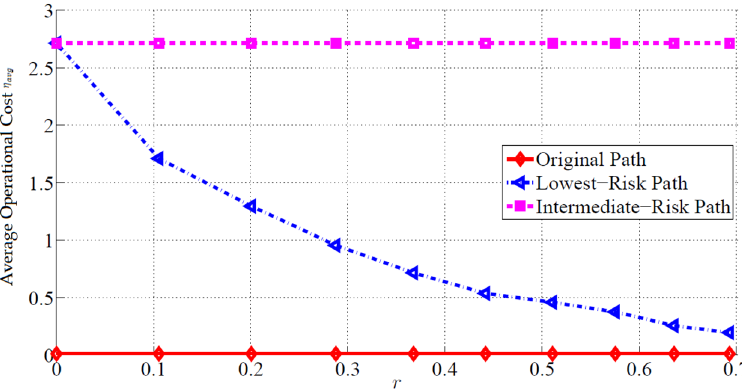
Figure 7. Average operation cost with adaptive risk threshold.